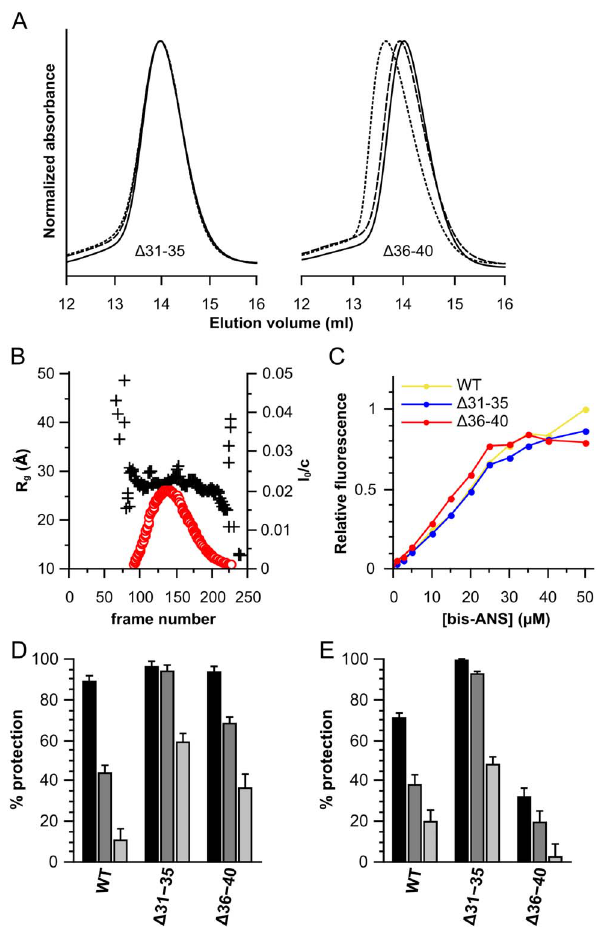
Figure 7. Characterization of the D 31–35 and D 36–40 deletion constructs of HSPB6. (A) Size-exclusion chromatography profiles, 100 m l of protein was loaded onto a Superdex 200 10/300 GL column at different concentrations. 2.5 mg/ml is shown as a solid line, 5 mg/ml as a dashed line and 10 mg/ml as a dotted line. The absorbance was normalized to the maximum for each curve. (B) SAXS analysis of D 31– 35. 250 frames were collected during elution from a Shodex KW-404F column. The radius of gyration (R g ) and forward scattering (I 0 ) were calculated at each measured point using buffer subtracted scattering curves that had been averaged by a ten-frame moving average algorithm to improve the signal-to-noise. The forward scattering values are normalized by dividing the values by the concentration of the sample at the peak maximum. The R g is plotted as a black cross and scaled on the left axis, the I 0 is shown as a red circle and scaled on the right axis. (C) Bis-ANS titration curves. 2.5 m M of protein was incubated with increasing concentrations of bis-ANS and fluorescence intensities were recorded at 490 nm with an excitation wavelength of 390 nm. HSPB6 is depicted in yellow, D 31–35 in blue and D 36–40 in red. (D) Chaperone-like activity using insulin as a substrate, the monomer mass molar ratios tested were 1:0.2 (black), 1:0.1 (dark gray) and 1:0.05 (light gray). (E) Chaperone-like activity using yADH. The ratios used are 1:2 (black), 1:1 (dark gray) and 1:0.5 (light